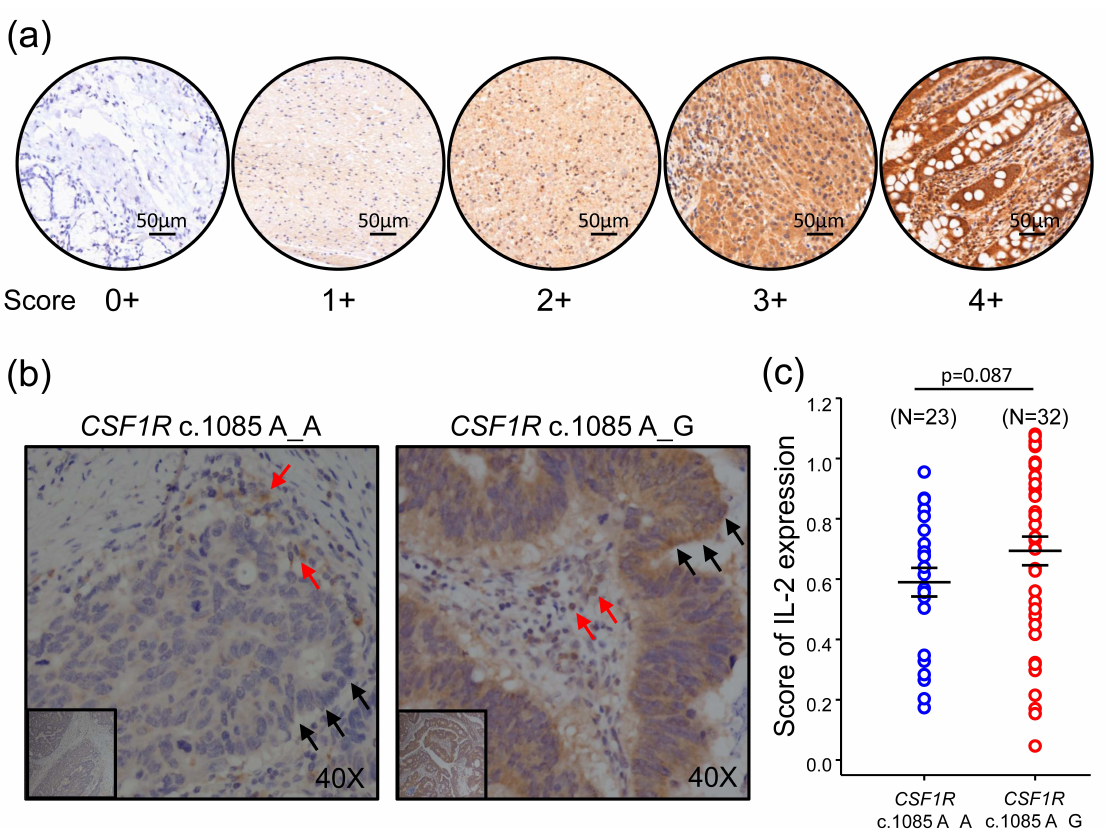
Figure 4. CRC with CSF1R c.1085 genotype A_G had higher IL-2 expression. ( a ) Representative images of CRC tumor speci- men staining with IL-2 antibody. The IL-2 staining was scored as 1, 2, 3, and 4, according to the intensity. ( b ) Representative images of IL-2 immunohistochemical staining in CRCs with CSF1R c.1085 genotype A_A and A_G. Black and red arrows indicate the tumor and immune cells, respectively. ( c ) Whole tissue was scanned with TissueFAXS Plus. The IL-2 expression was determined in 5 randomly selected tumor fields by HistoQuest. Each field was 1.2 × 1.2 mm 2 . The IL-2 expression level was compared between the group of CSF1R c.1085 genotype A_A and A_G. Solid lines, mean +/ − SEM. Parentheses indicate case number in each